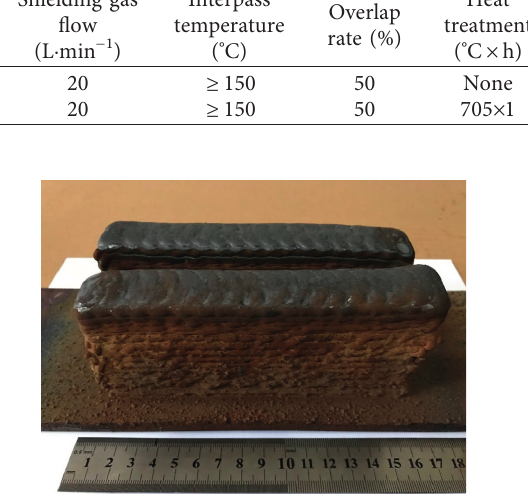
Figure 1: Schematic of a 2.25Cr1Mo0.25V heat-resistant steel sample produced by WAAM.